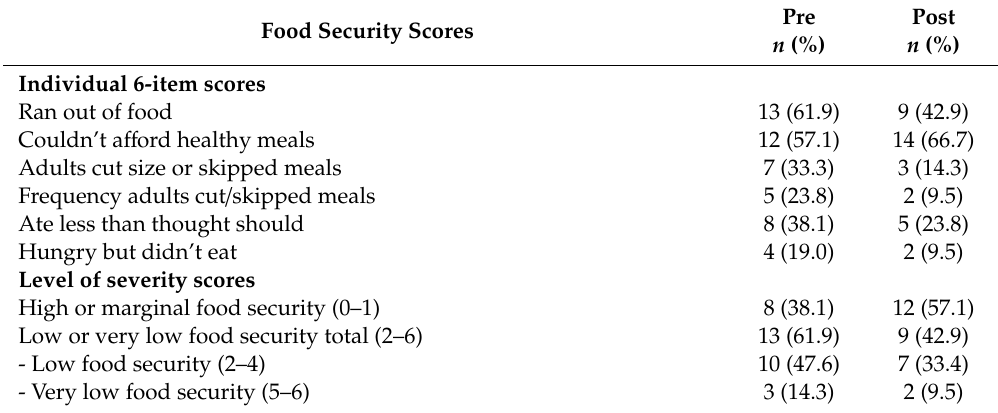
Table 3. Participant’s food security scores (6-item USDA FSM) ( n = 21).